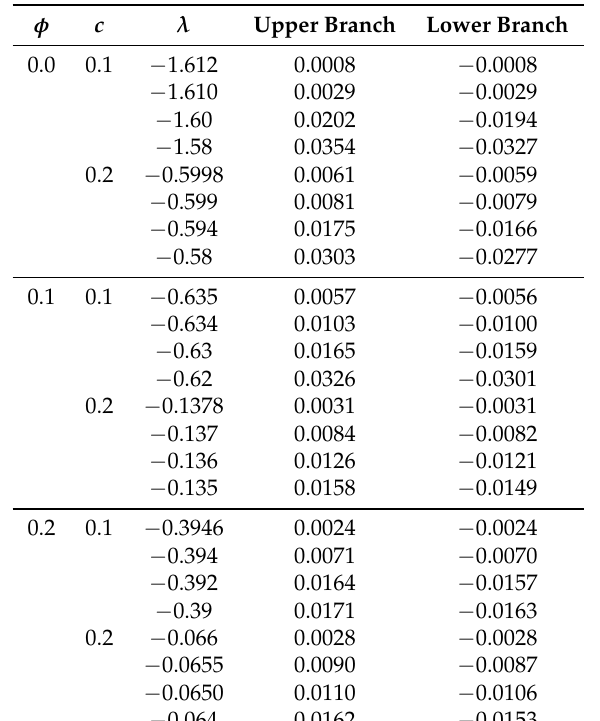
Table 2. Smallest eigenvalues γ for different values of nanoparticle volume fraction φ , needle size c and mixed convection parameter λ when ε = − 2 for Cu nanoparticles.